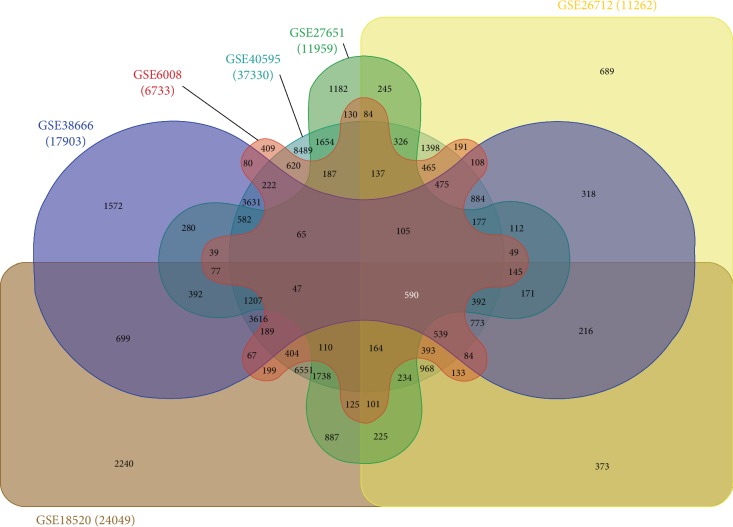
Human datasets of ovarian cancer and normal sample tissues. Samples were obtained from six independent gene transcript datasets containing HGSOC and normal ovarian cases. To identify genes (common probe IDs) consistently deregulated in HGSOC, a fold-change cutoff of 1.5 and adjusted p-value <0.05 were used for each dataset.